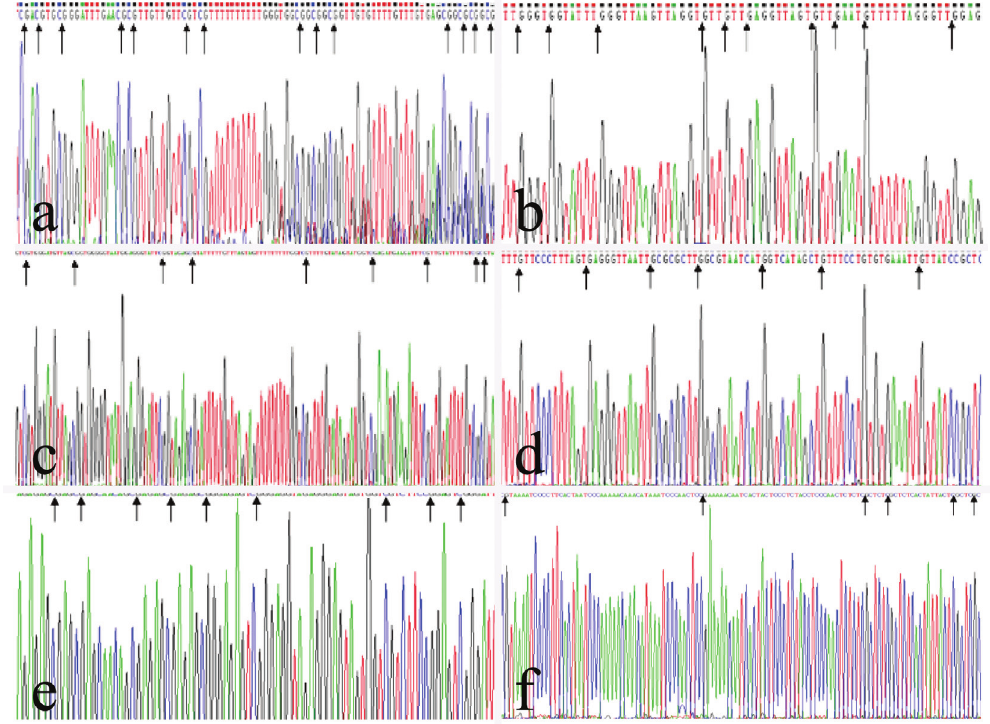
Figure 2 - Sequencing of MSP products. Methylated C in CpG loci remained unchanged whereas unmethylated C residues were modified into T (partial modifications do not change into T). A, B: methylation in the promoter region of the WT1 gene; C, D: methylation in the promoter region of the NKX6-1 gene; E, F: methylation in the promoter region of the DBC1 gene. Left lane: methylation products; right lane: unmethylated products; arrows indicate CpG